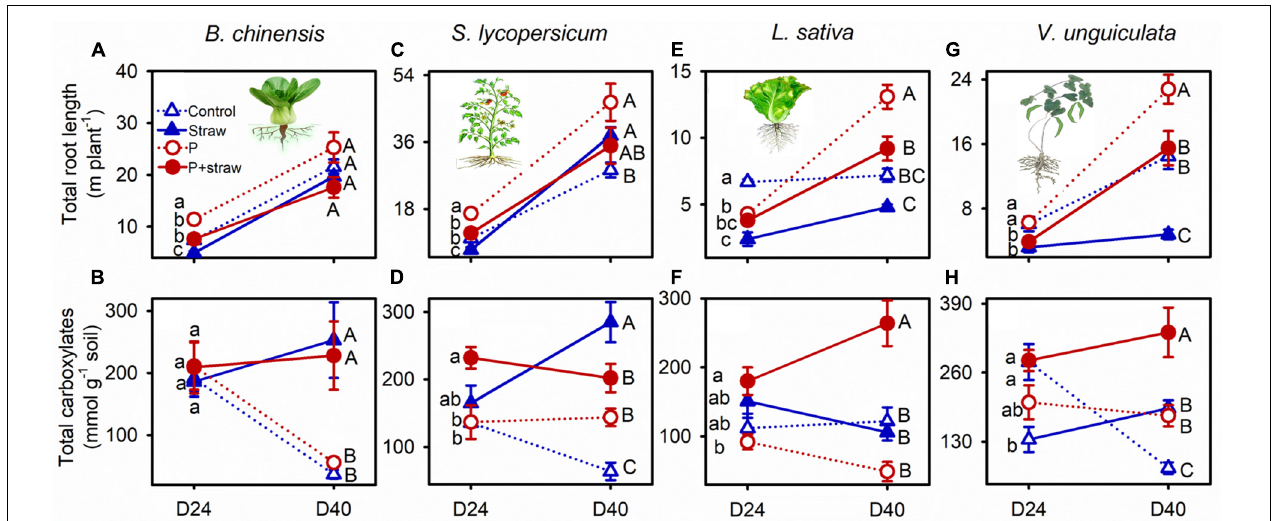
FIGURE 2 | Effects of straw addition and P fertilization on root length and exudation of carboxylates in the rhizosphere of B. chinensis (A,B) , S. lycopersicum (C,D) , L. sativa (E,F) , and V. unguiculata (G,H) at days 24 and 40. Control: no fertilizer P or straw; straw: no P but with straw addition; P: fertilizer P at 100 mg P kg − 1 soil; P + straw: fertilizer P at 100 mg P kg − 1 soil together with straw addition. D24: 24 days after straw addition, and D40: 40 days after straw addition. Data are means ± SE ( n = 4). For each crop species and a given parameter, the lowercase letters denote significant differences ( p ≤ 0.05) among treatments without P or straw, with straw but no fertilizer P, with fertilizer P but no straw, and with fertilizer P and straw at day 24, and the capital letters denote significant differences ( p ≤ 0.05) among the four treatments at day 40.